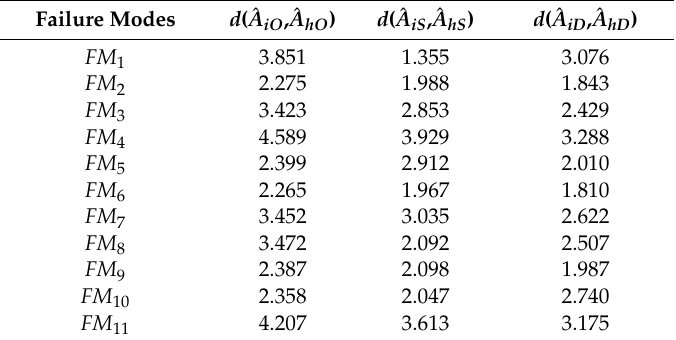
Table 6. Relevant parameters of objective weight.